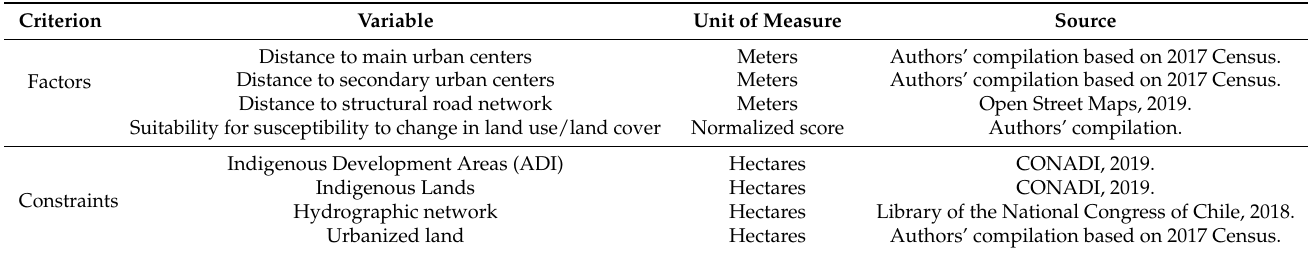
Table 2. Factors and constraints considered for MCE-MOE. Source: Authors’ compilation. Criterion Variable Unit of Measure